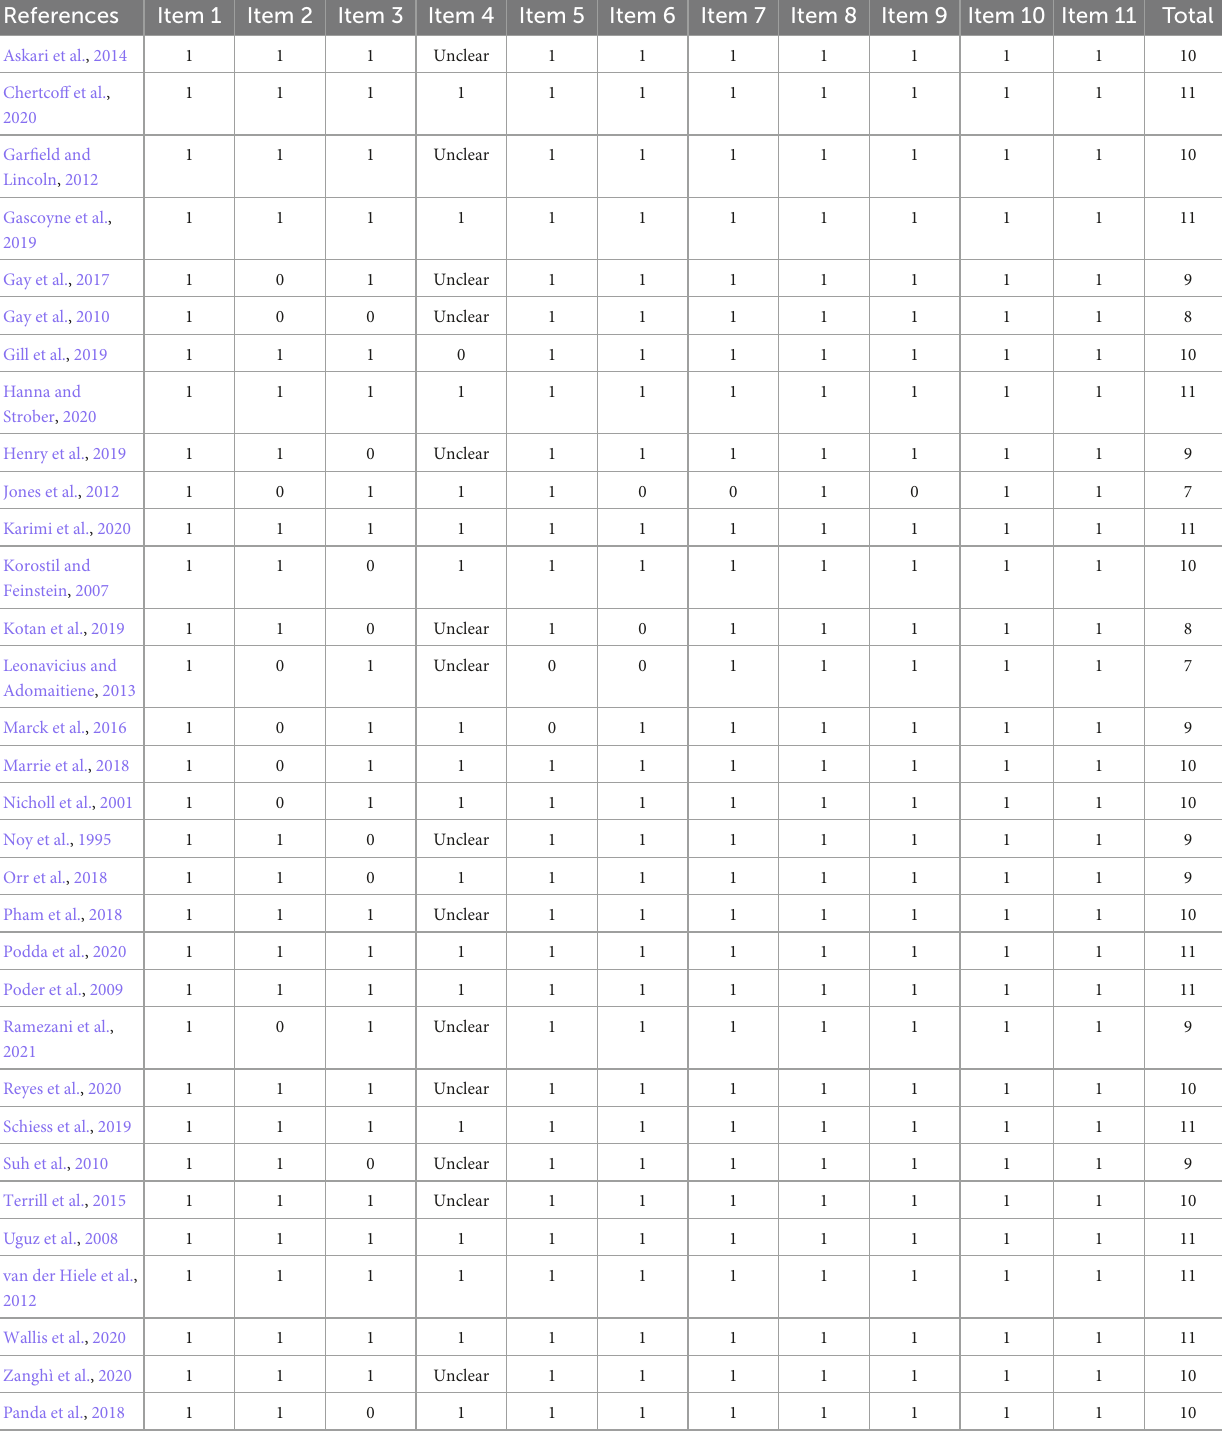
TABLE 2 Agency for Healthcare Research and Quality assessment of included